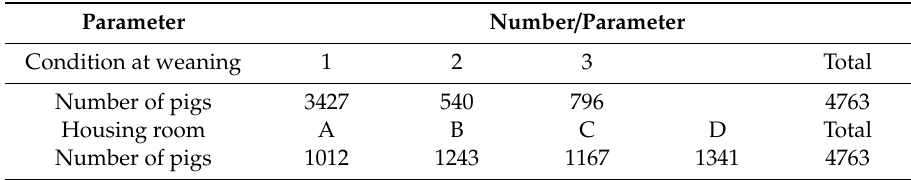
Table 1. Experimental setup: animals per specific condition at weaning and per housing room. Condition at weaning: Group 1: pigs purchased from other farms, no data about vaccination against Mycoplasma hyopneumoniae were available; Group 2: pigs purchased from other farms, pigs were vaccinated with Stellamune One (Pfizer Animal Health) against Mycoplasma hyopneumoniae just after arrival in the ZTC; Group 3: pigs bred at the ZTC and were vaccinated with Stellamune Mycoplasma (Pfizer Animal Health) at day 7 and day 28 after